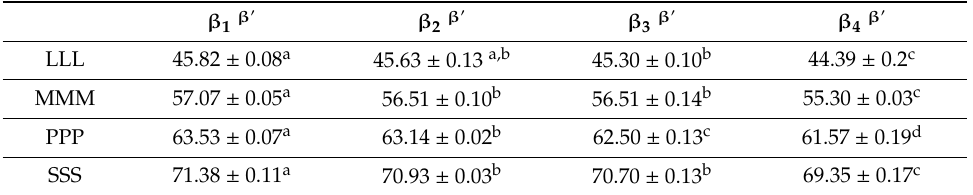
Different letters in the same row show significant difference ( p < 0.05). Errors represent the sample standard deviations.